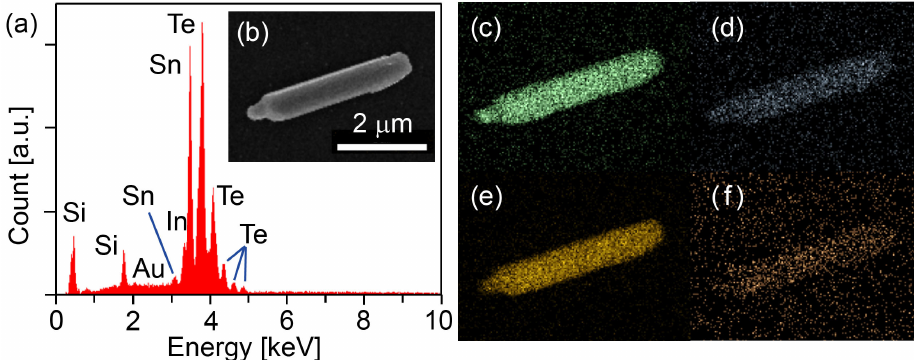
Figure 3. (Color online) Investigation of the constituent elements in the indium-doped tin telluride (In-SnTe) nanostructures grown by the vapor transport growth (VTG) method on a Si substrate under the vapor-liquid-solid (V–L–S) mechanism with the use of 20-nm GNPs. ( b ) Scanning electron microscope (SEM) topography of a typical nanorod on a Si substrate. ( a ) Energy dispersive X-ray (EDX) spectra taken from a point analysis in the middle of the sample in ( b ). ( c – f ) EDX spectroscopy elemental mappings for ( c ) Sn, ( d ) In, ( e ) Te, and ( f ) Au of the sample in ( b ), respectively. Scale bar in ( b ) is 2 µ